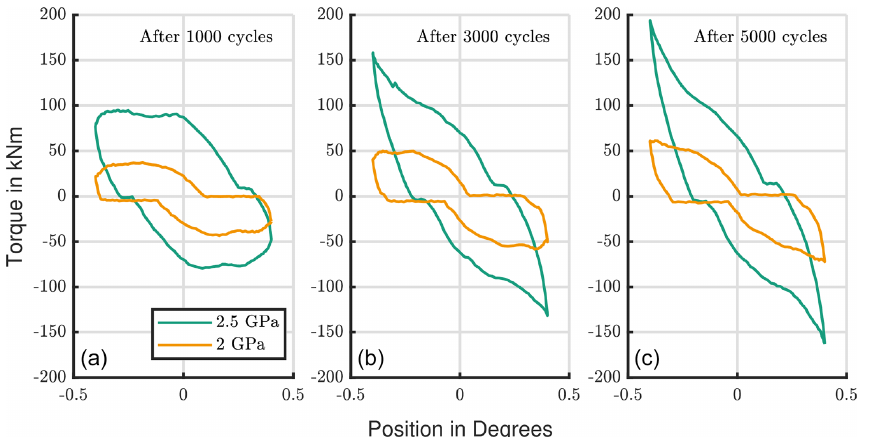
Figure 7. Torque development: comparison of contact pressures of 2.5GPa (ID I) and 2.0GPa (ID II).